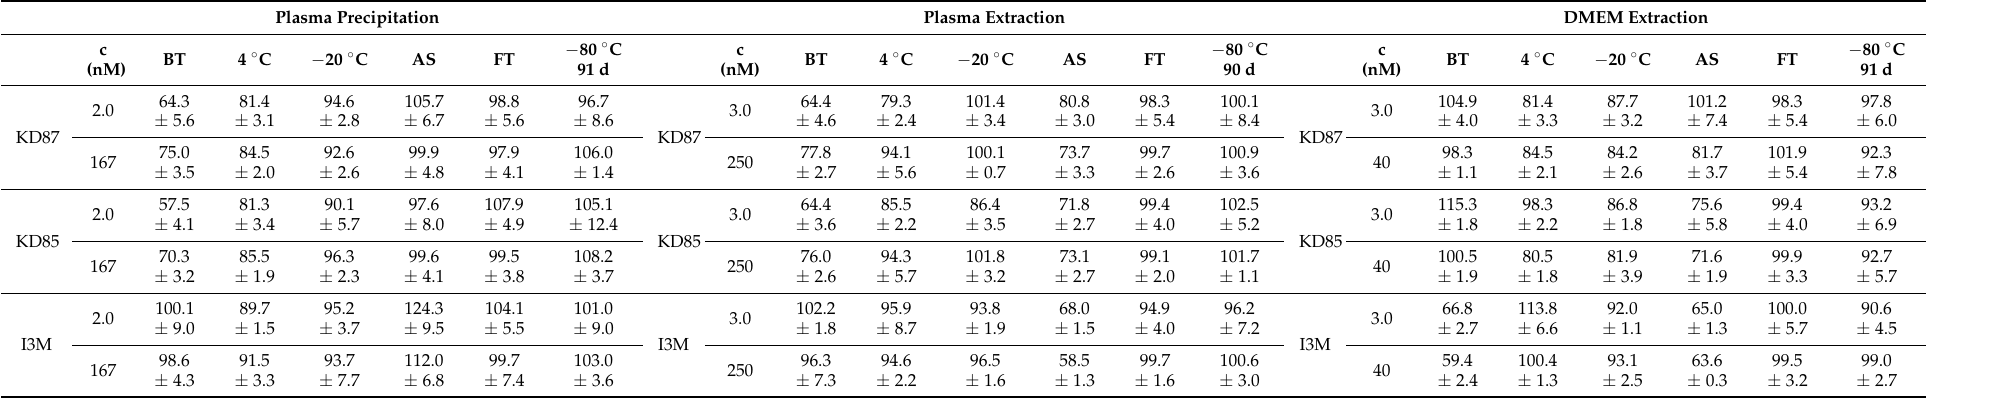
Table 7. Stability of KD87, KD85, and I3M analytes after plasma precipitation, plasma extraction, or DMEM extraction under various storage conditions, i.e., benchtop (BT), 4 ◦ C, − 20 ◦ C, autosampler (AS), freeze-thaw (FT), and long-term freezing (90 or 91 days at − 80 ◦ C). The duration of storage was 24 h unless stated otherwise. Values are mean percentages ± standard deviation (SD) of n =